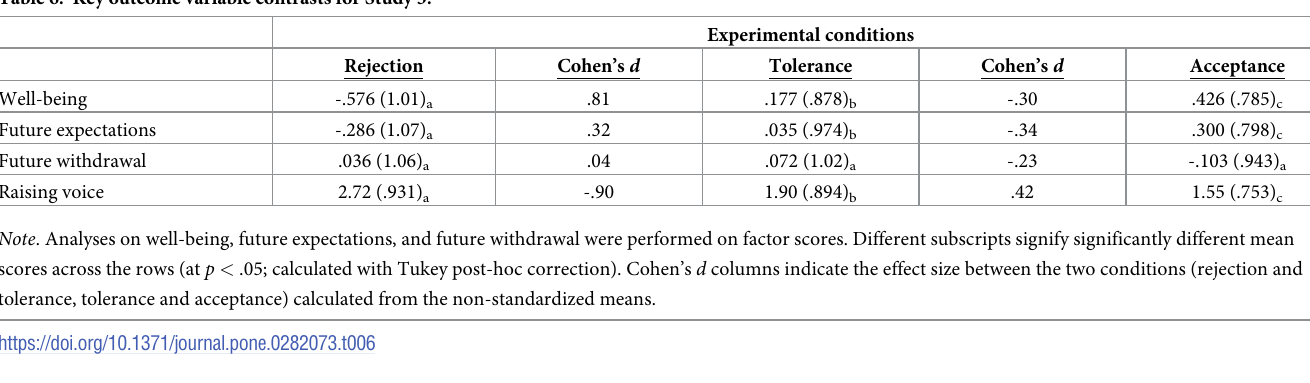
Table 6. Key outcome variable contrasts for Study